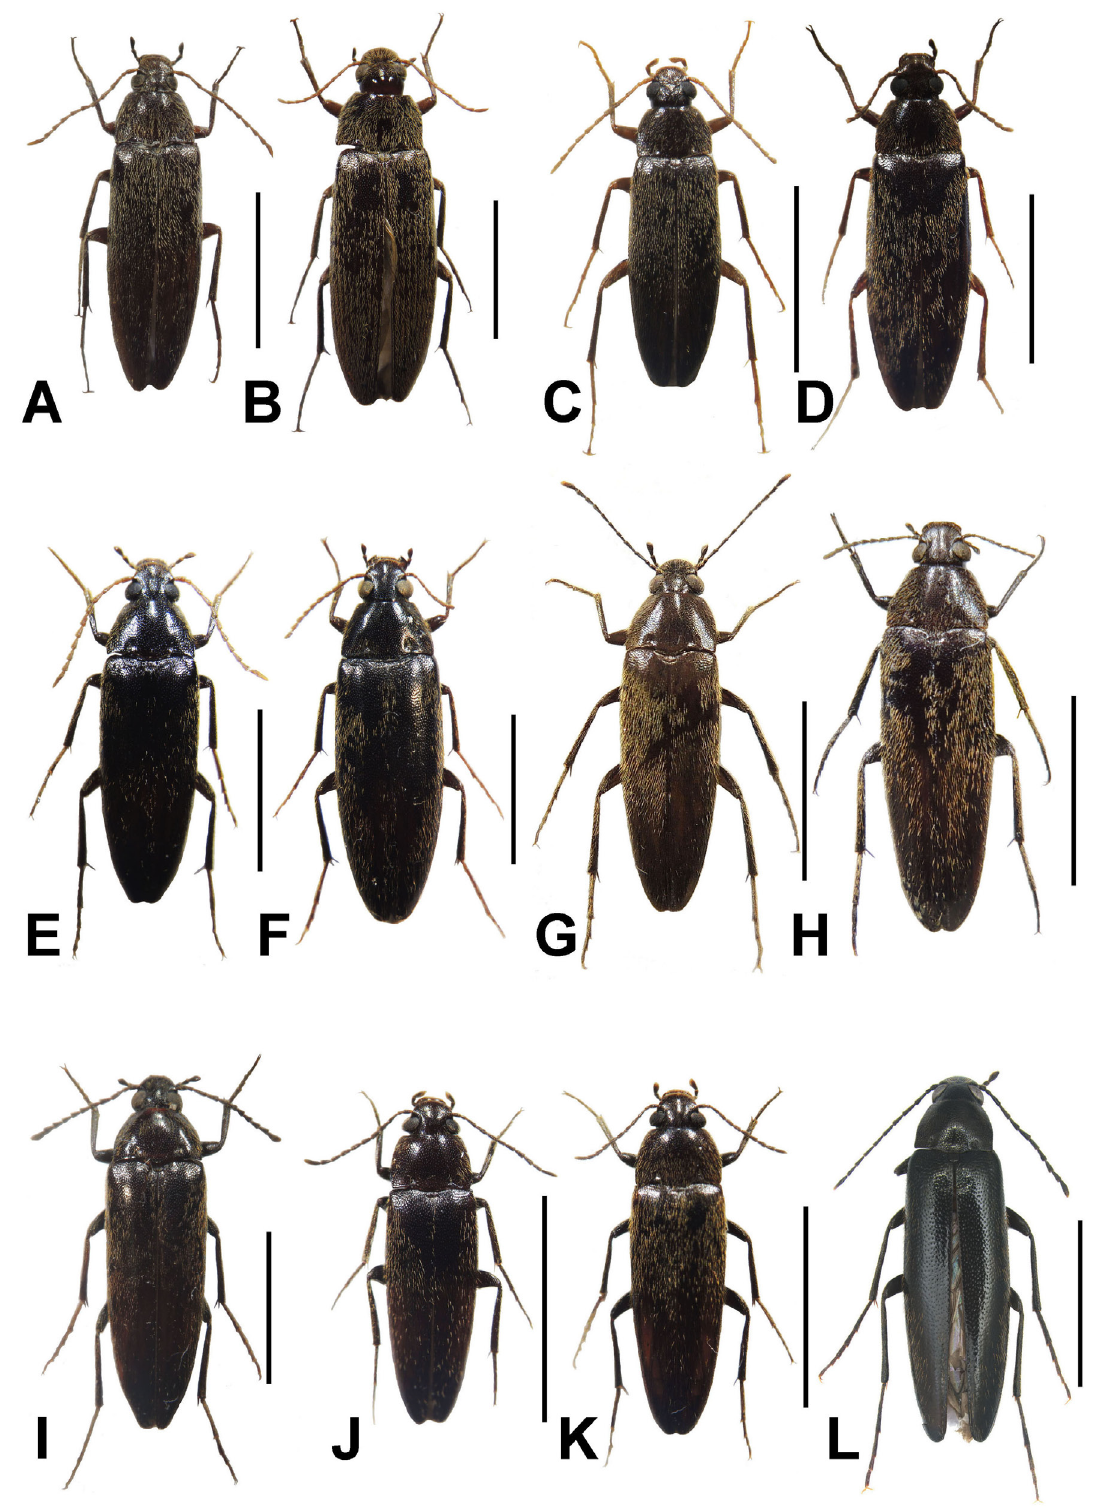
Fig. 3. Habitus, dorsal view. A–B . Synchroa punctata Newman, 1838. C–D . S. melanotoides